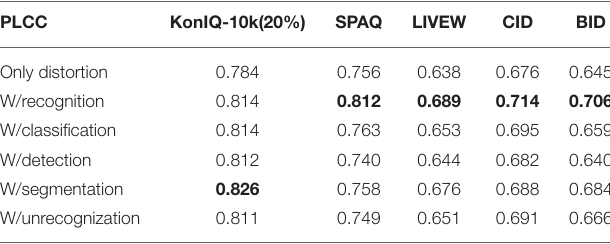
TABLE 5 | Results of training the distortion network from scratch on 80% Smartphone Photography Attribute and Quality (SPAQ).